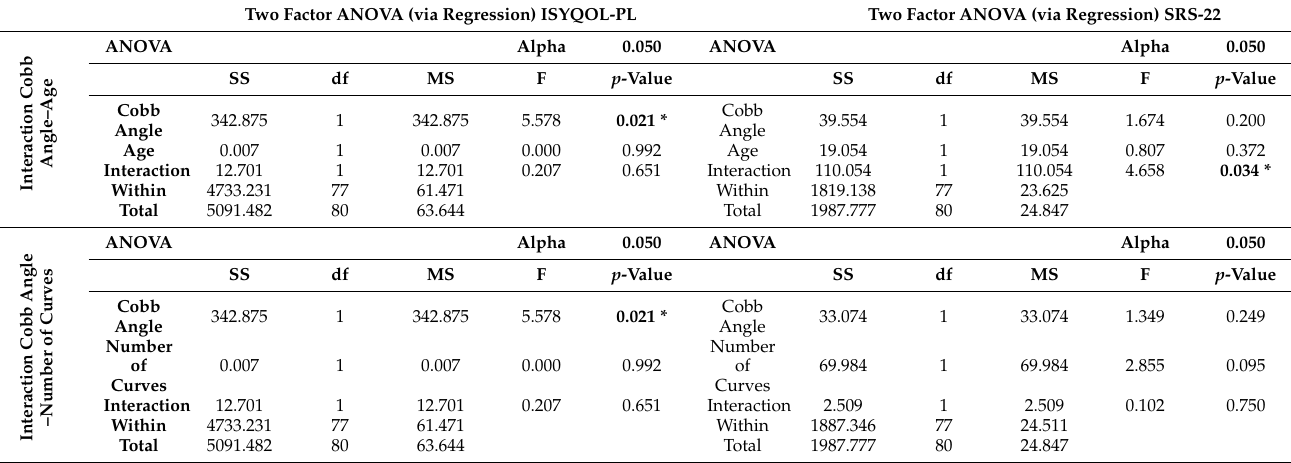
Table 3. Two-way ANOVA analysis to study the interaction of scoliosis severity level and age and years of treatment on patients’ perceived HRQoL measured with the ISYQOL-PL and the SRS-22 questionnaires. Two Factor ANOVA (via Regression) ISYQOL-PL Two Factor ANOVA (via Regression)